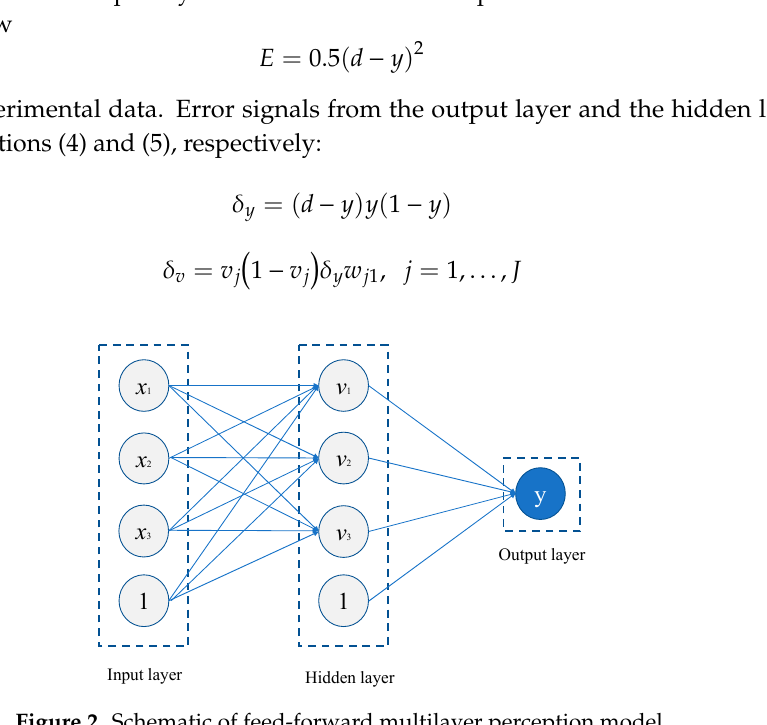
Figure 2. Schematic of feed-forward multilayer perception model.